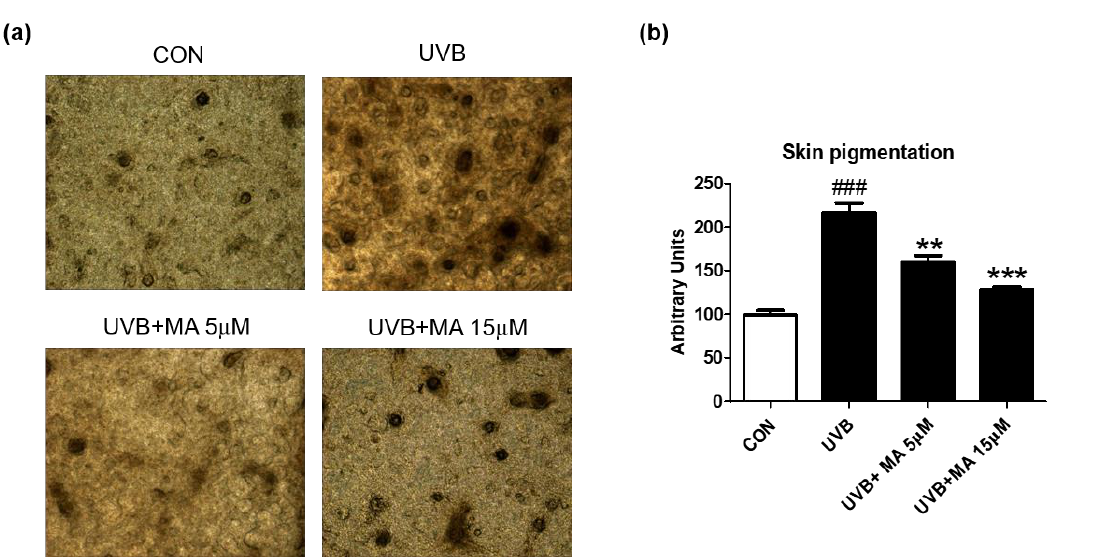
Figure 4. Inhibitory effect of maclurin on melanogenesis in 3D artificial human skin. The pigmented human skin model (Neoderm-ME) was pretreated with maclurin and exposed to UVB radiation, followed by incubating in the maintenance media offered by the company for 5 days. ( a ) Microscope images of 3D skin ME model, which is pretreated with DMSO or maclurin, and then exposed to UVB (10 mJ) or not. ( b ) The pigmentation of the skin was analyzed by the Image J software program. The results were represented the mean value ± SEM at least three times. All data were compared by ANOVA, followed by Dunnett ’ s multiple comparison test. ### p < 0.001 compared with the control group and ** p < 0.01, *** p < 0.001 compared to the UVB-exposed group.